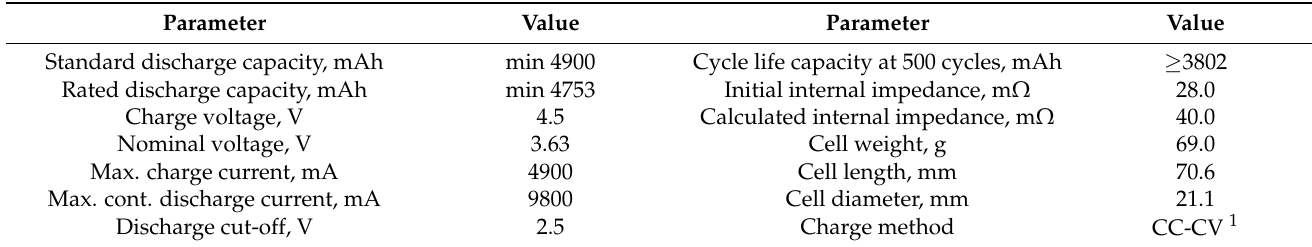
Table 1. Specification of the Li-ion battery used as a test model.